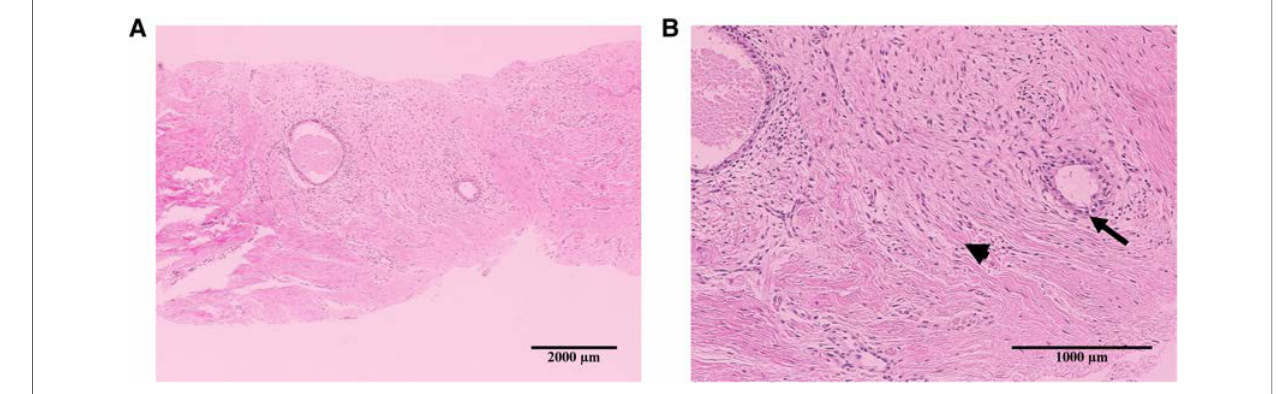
FIGURE 2 Representative images of hematoxylin – eosin staining in the histological specimen of abdominal wall endometriosis. The nodule shows scarce endometrial glands (arrowheads) and stroma (arrows) in the abdominal wall: 4× ( A ) and 10× ( B ).